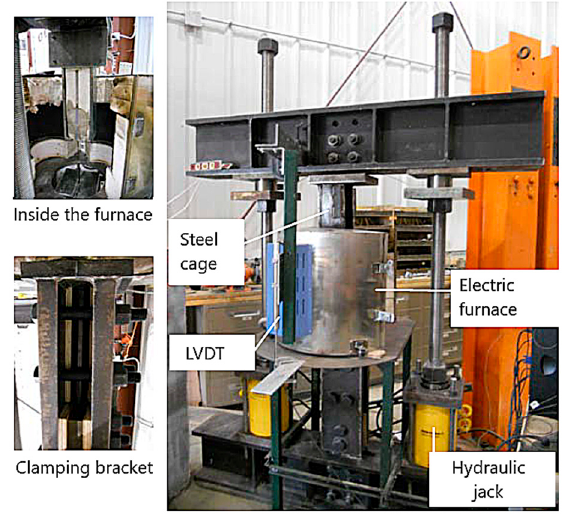
Figure 7. Test setup for evaluating bond strength of NSM FRP systems at high temperatures.